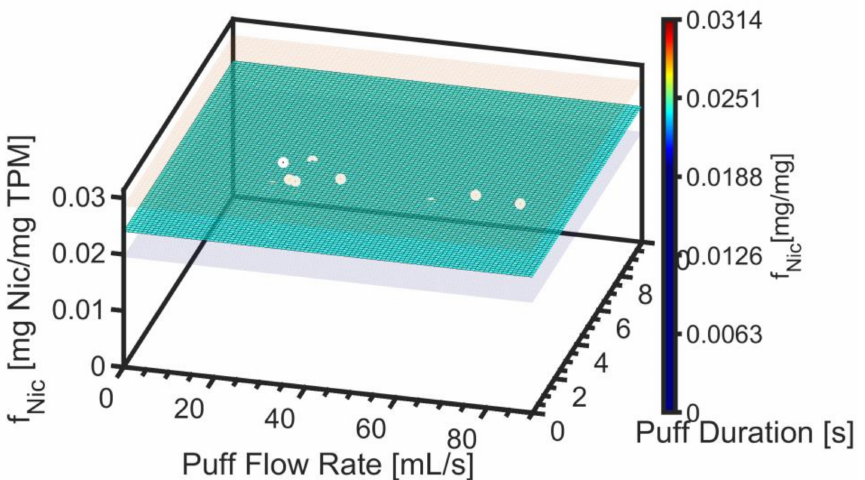
Figure 5. Product EC14-01. Screening emissions model for nicotine mass ratio is illustrated as the colored surface plot, with semitransparent surfaces above and below the model surface to reflect the 95% confidence interval on the nonlinear regression. Underlying data are illustrated with markers.